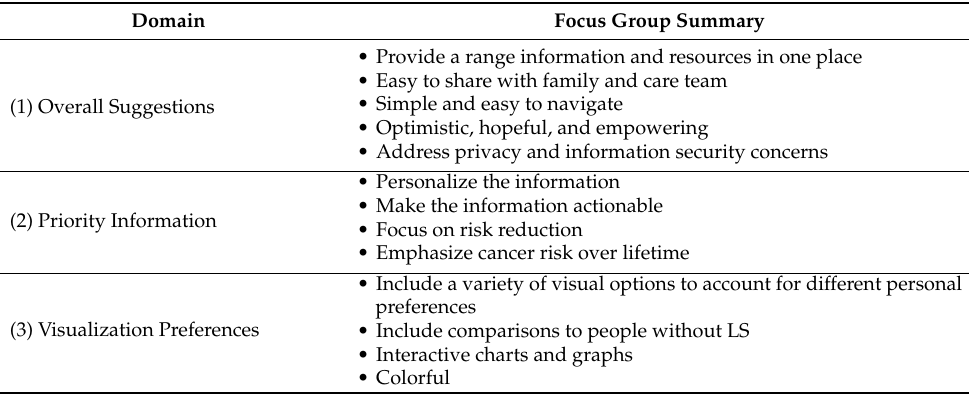
Table 4. Summary of identified domains in the focus